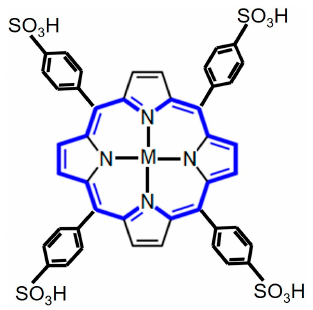
Figure 4. Typical structure of meso -sulphonatophenyl porphyrin which can be used as a contrasting agent for MRI (M = Cu(II), Fe(III), or